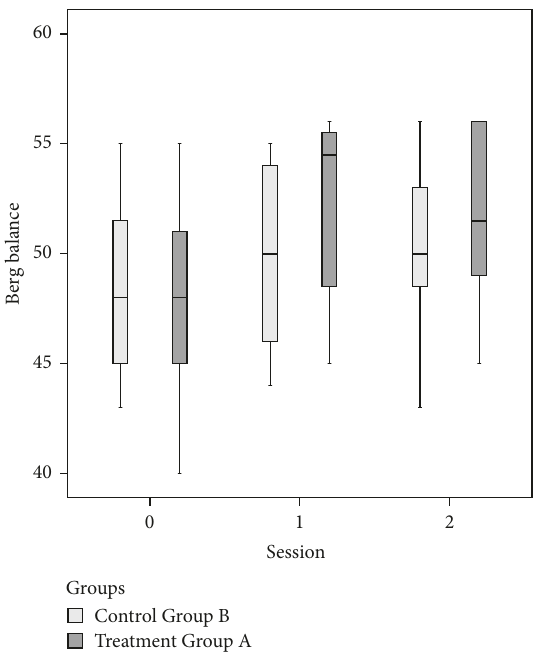
Figure 4: Berg Balance Scale (BBS) at baseline (= T 0) and at the end of the treatment (= T 1) and follow-up (= T 2) for the two groups.